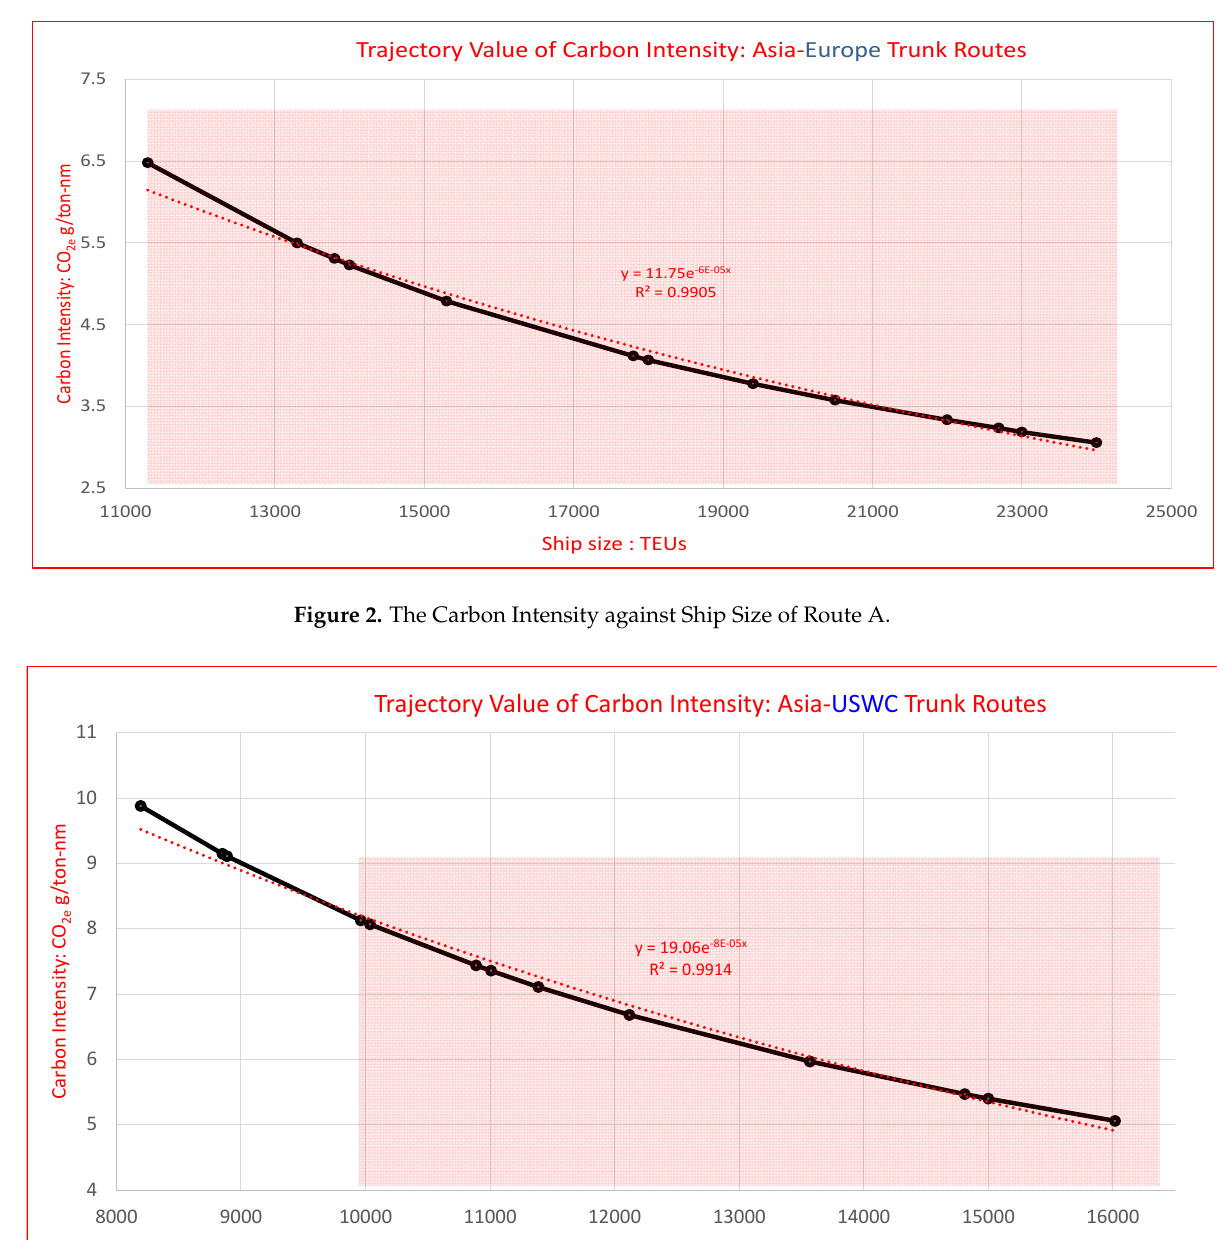
Ship size : TEUs Figure 3. The Carbon Intensity against Ship Size of Route B.